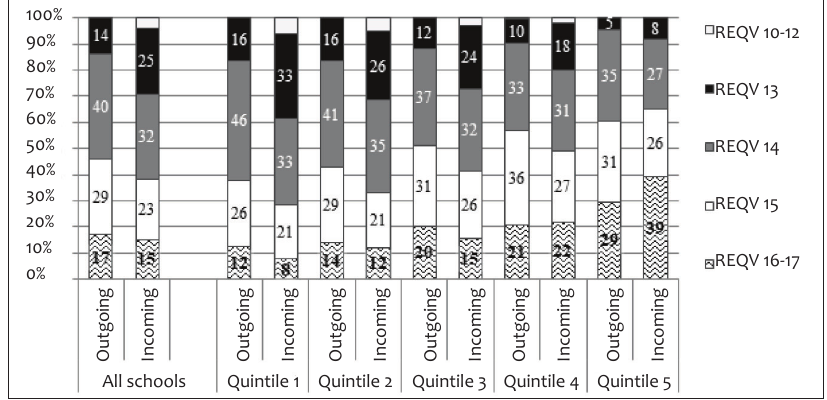
Figure 4: Qualifications (REQV) of outgoing and newly appointed principals Source: Persal-EMIS matched dataset. Notes: Outgoing principals are